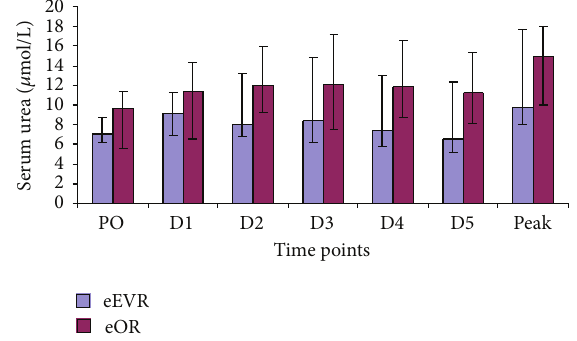
Figure 2: Serum creatinine concentrations in the eEVAR versus eOR groups at PO ( 𝑃 = 0.755 ), D1 ( 𝑃 = 0.493 ), D2 ( 𝑃 = 0.333 ), D3 ( 𝑃 = 0.645 ), D4 ( 𝑃 = 0.810 ), D5 ( 𝑃 = 0.549 ), and the peak ( 𝑃 = 0.467 ) expressed as median and IQR (Mann-Whitney 𝑈 test).